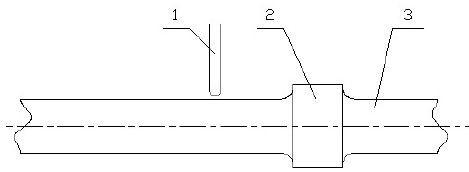
Figure 1. Schematic of contact-type detection: 1—contact probe; 2—drill-stem joint; 3—drill stem.